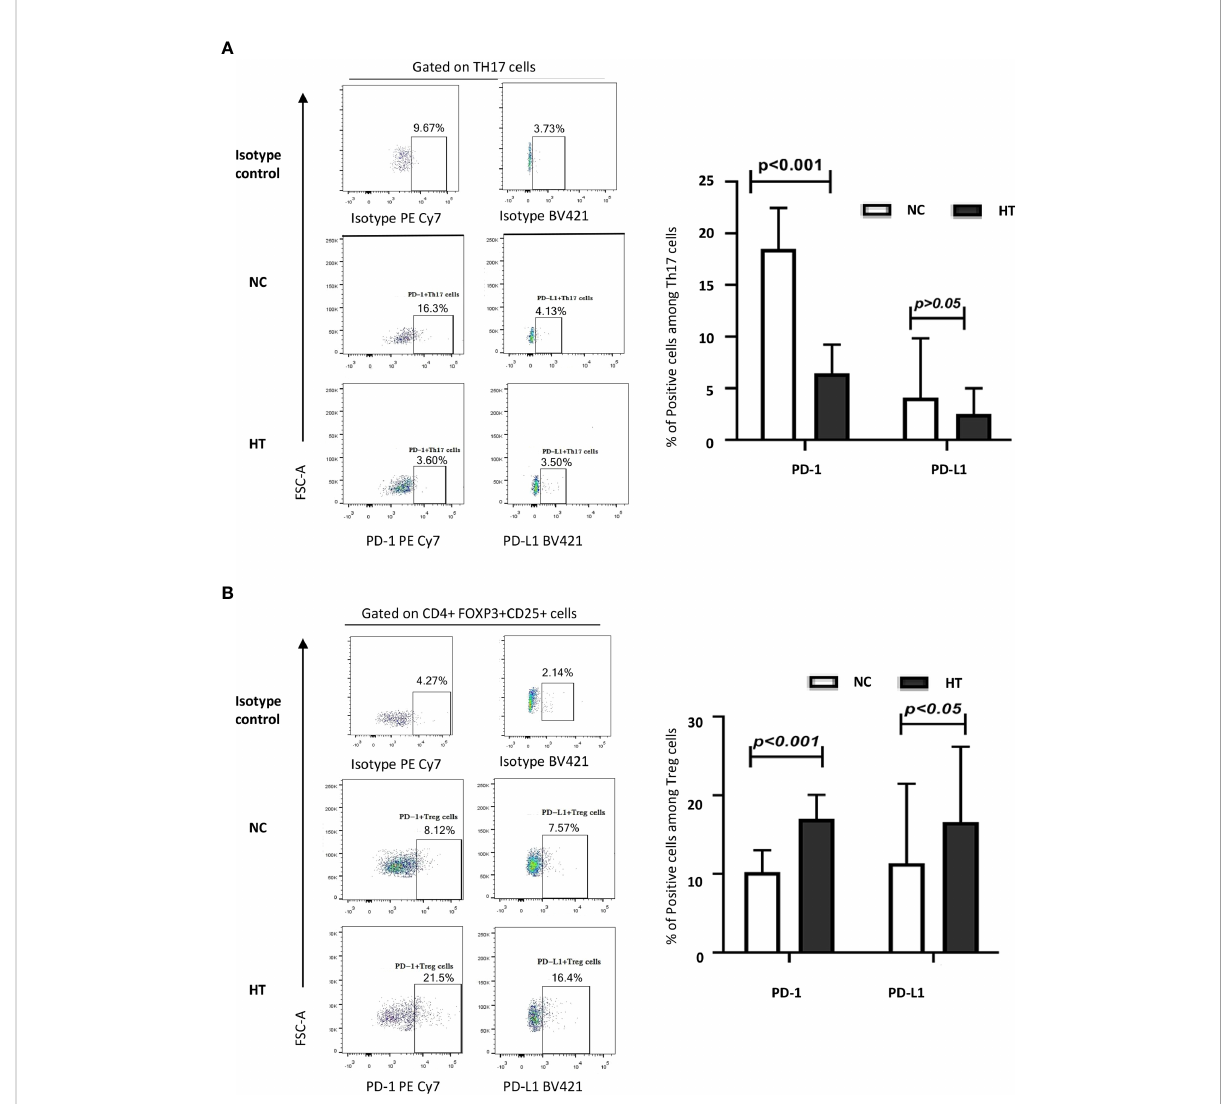
FIGURE 2 Comparison of the expression of PD-1 and PD-L1 on peripheral blood Th17s and Tregs from NC and HT patients. The percentages of IL-17 + Th17s expressing PD-1 and PD-L1 (A) , and the percentages of CD25 + FOXP3 + Tregs expressing PD-1 and PD-L1 (B) among the peripheral blood CD4 T cells of NC and HT patients was quanti fi ed by fl ow cytometric analysis. Representative dot plots display PD-1 and PD-L1 positive cells based on negative controls using isotype control antibodies. The bar charts on the left-hand side summarize the data obtained for the NC (n = 21) and the HT (n = 53) groups. Differences between groups were assessed by t-test and the p-values are